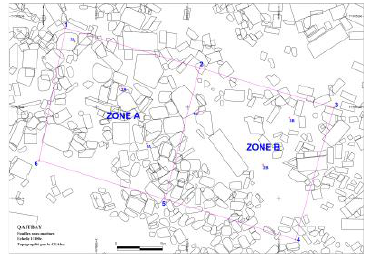
Figure 3. Zone 1, initial sector of data acquisition (CEAlex) Zones A and B were partitioned into 2 m wide lanes running transversally over an area of 15 m by 30 m, marked out by ropes attached to iron rods (fig.4). At the beginning the